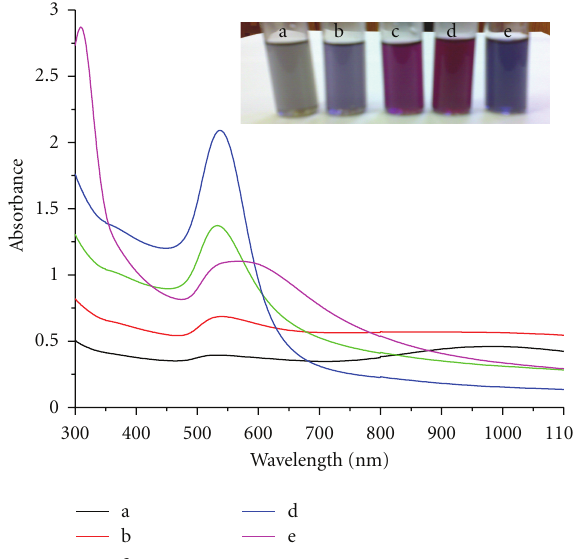
Figure 1: UV-vis spectra of AuNPs of various concentration (a) 0 . 25 × 10 − 3 , (b) 0 . 50 × 10 − 3 , (c) 0 . 75 × 10 − 3 , (d) 1 . 00 × 10 − 3 , and (e) 2 . 00 × 10 − 3 M of HAuCl 4 solution using 1 × 10 − 3 M TPB as reductant. Inset . Photographic images show di ff erent colors of AuNPs in various concentrations such as (a) 0 . 25 × 10 − 3 M, (b) 0 . 50 × 10 − 3 M, (c) 0 . 75 × 10 − 3 M, (d) 1 . 00 × 10 − 3 M, and (e) 2 . 00 × 10 − 3 M of HAuCl 4 solution using 1 × 10 − 3 M TPB as reductant. to improve the particle stability using stabilizers, we found but to also confer chemical sensing ability to the